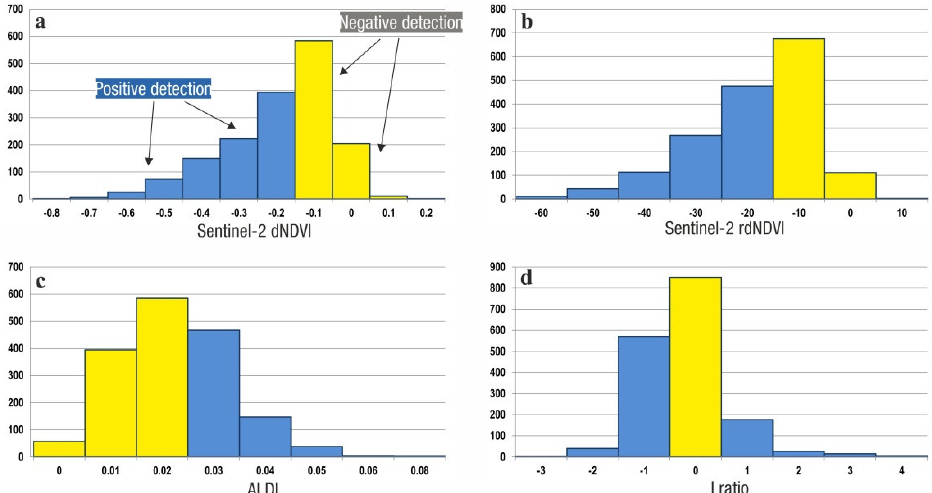
Figure 17. Histograms of pixel values by automated mapping methods corresponding to mapped landslides; ( a ) [46], ( b ) HazMapper by [44], ( c ) ALDI [47] and ( d ) SAR backscatter change by [45]. Yellow bars mark negative detections and blue bars positive detection, based on set threshold values for each method.